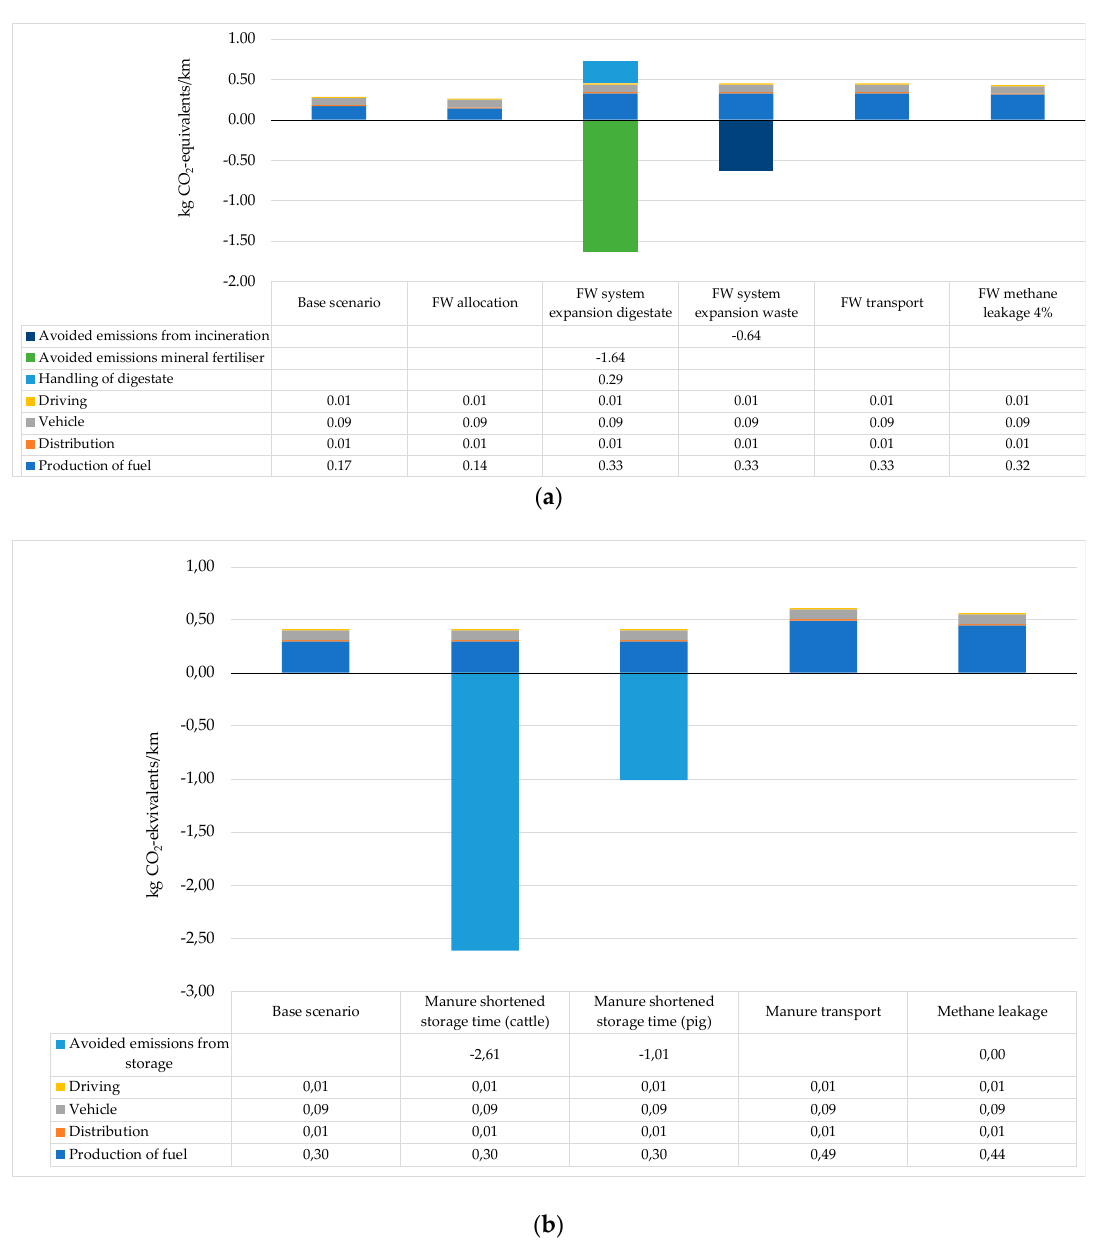
Figure 2. Sensitivity assessment for biogas as a fuel for transport produced from: ( a ) Food waste and ( b ) manure.